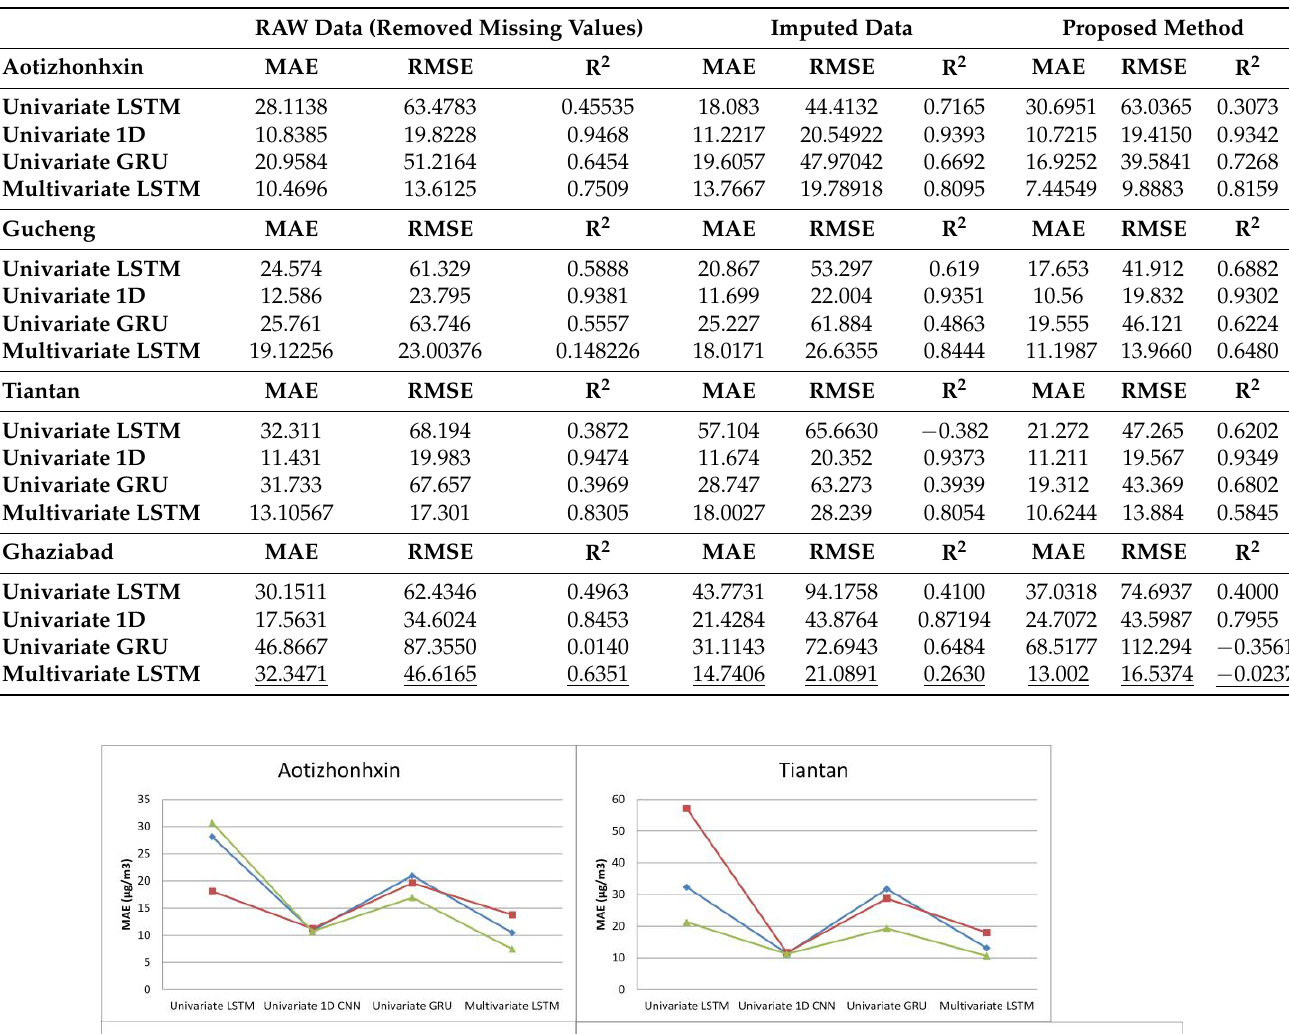
Table 4. Summary of results of experimentation performed on the dataset of four cities.